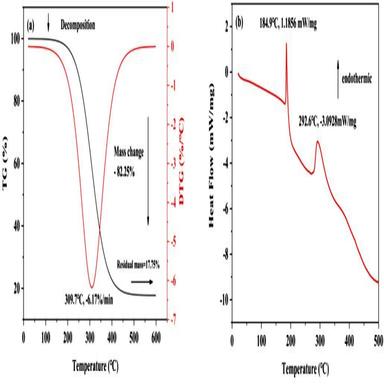
(a) TG/DTG curve of DADMQ. (b) DSC curve of DADMQ.